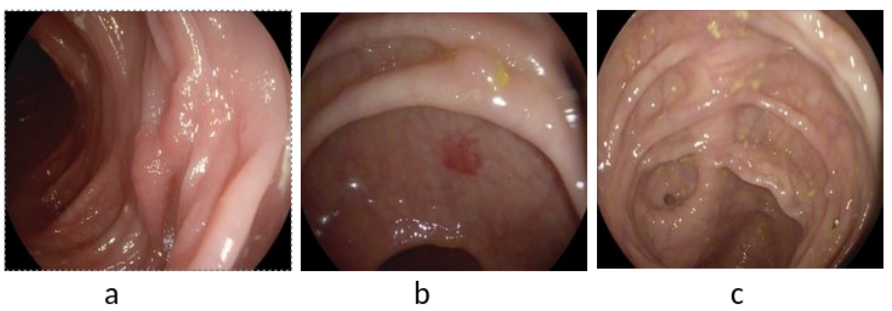
Figure 8. Example of CVC-ClinicDB polyp images ( a – c ).